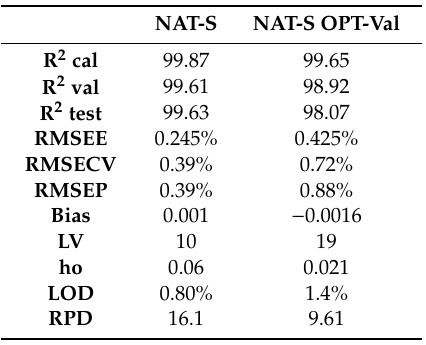
Table 5. Performance indicators parameters for the NAT-S